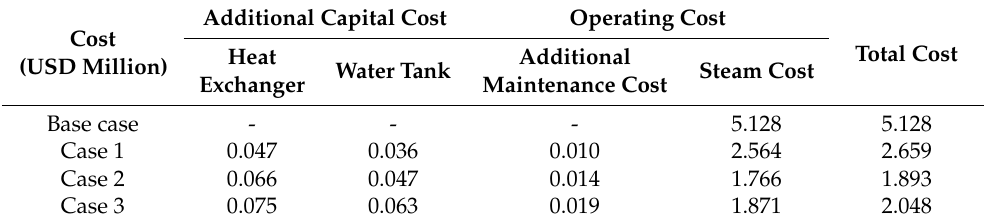
Table 11. Details of the economic analysis.